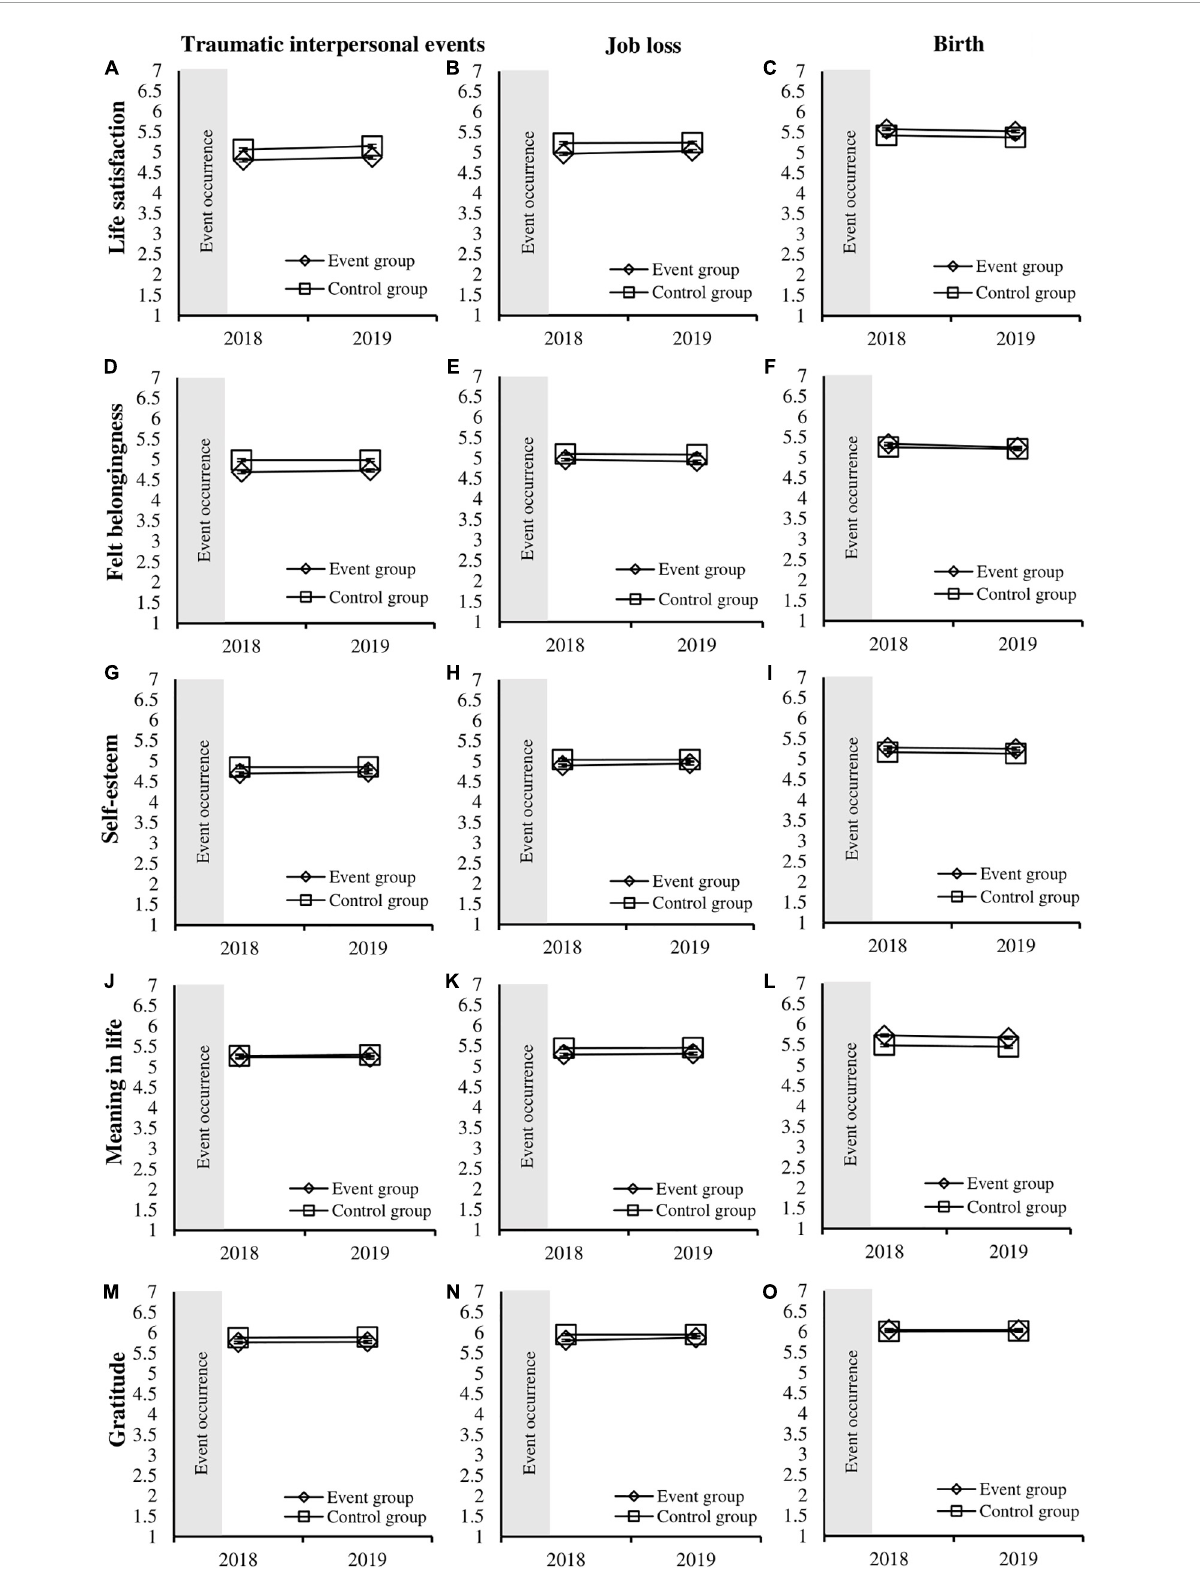
FIGURE1 Average levels (with standard errors) of life satisfaction, felt belongingness, self-esteem, meaning in life, and gratitude in 2018 and 2019 across matched event and control groups for traumatic interpersonal events, job loss, and birth (A–O) .